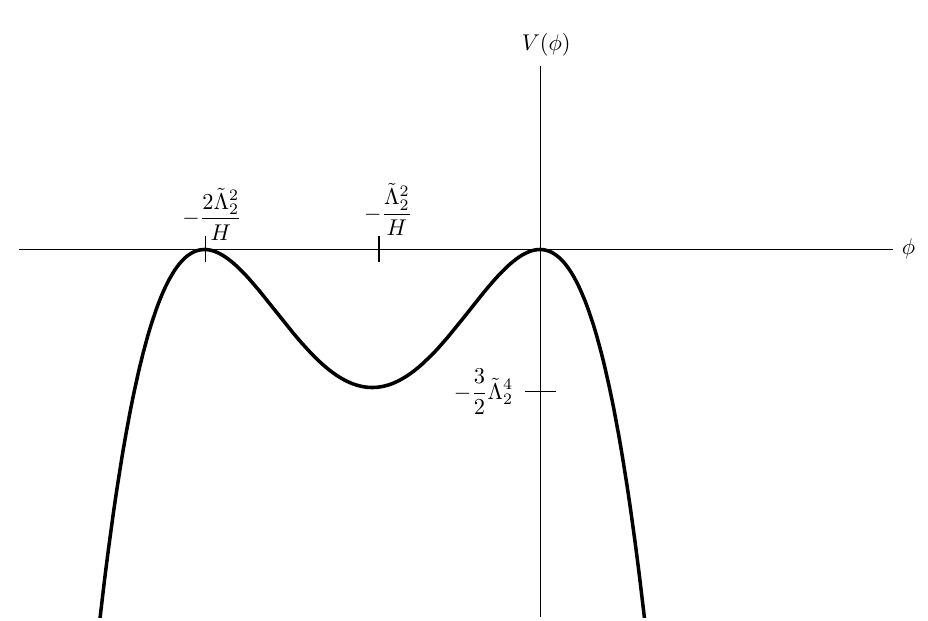
Figure 2 . Scalar potential in the ~(cid:3)